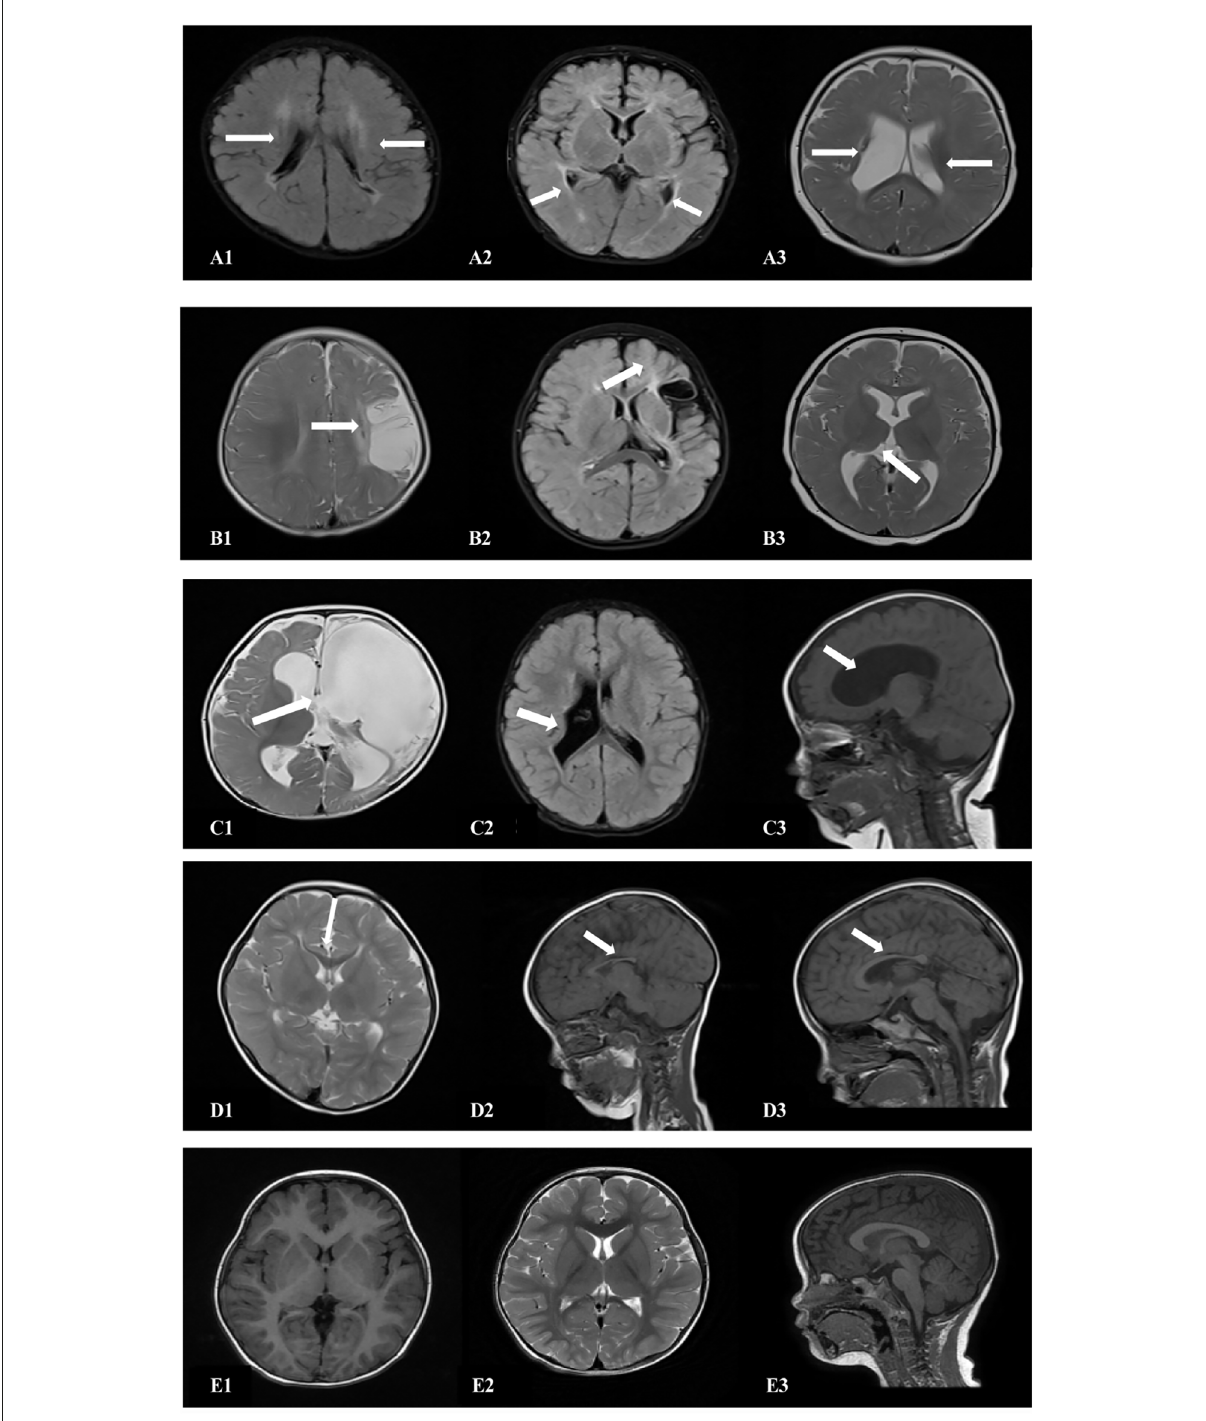
FIGURE4 Cranial MRI findings of the 18 patients in the ST group. (A1,2) (transverse): Irregularly shaped bilateral ventricles with nearby, irregular, patchy T1 and T2 hypersignals. (A3) (transverse section): Enlarged bilateral ventricles with nearby, patchy T2 signals. (B1) (transverse section): Left frontotemporal parietal atrophy with subcortical softening foci. (B2) (transverse section): Reduced volume of the left basal ganglia. (B3) (transverse section): Decreased volume of the left thalamus. (C1) (transverse): Left partial cerebral perforation malformation with supratentorial hydrocephalus. (C2) (transverse section): Right ventricular para-body brain penetration malformation with surrounding gliosis. (C3) (sagittal section): Supratentorial hydrocephalus. (D1) (transverse section): Thinning of the corpus callosum. (D2) (sagittal): Noticeably thinner and shorter corpus callosum. (D3) (sagittal section): Significantly shorter corpus callosum. (E1–3) (TI/T2 transverse/sagittal): Normal brain